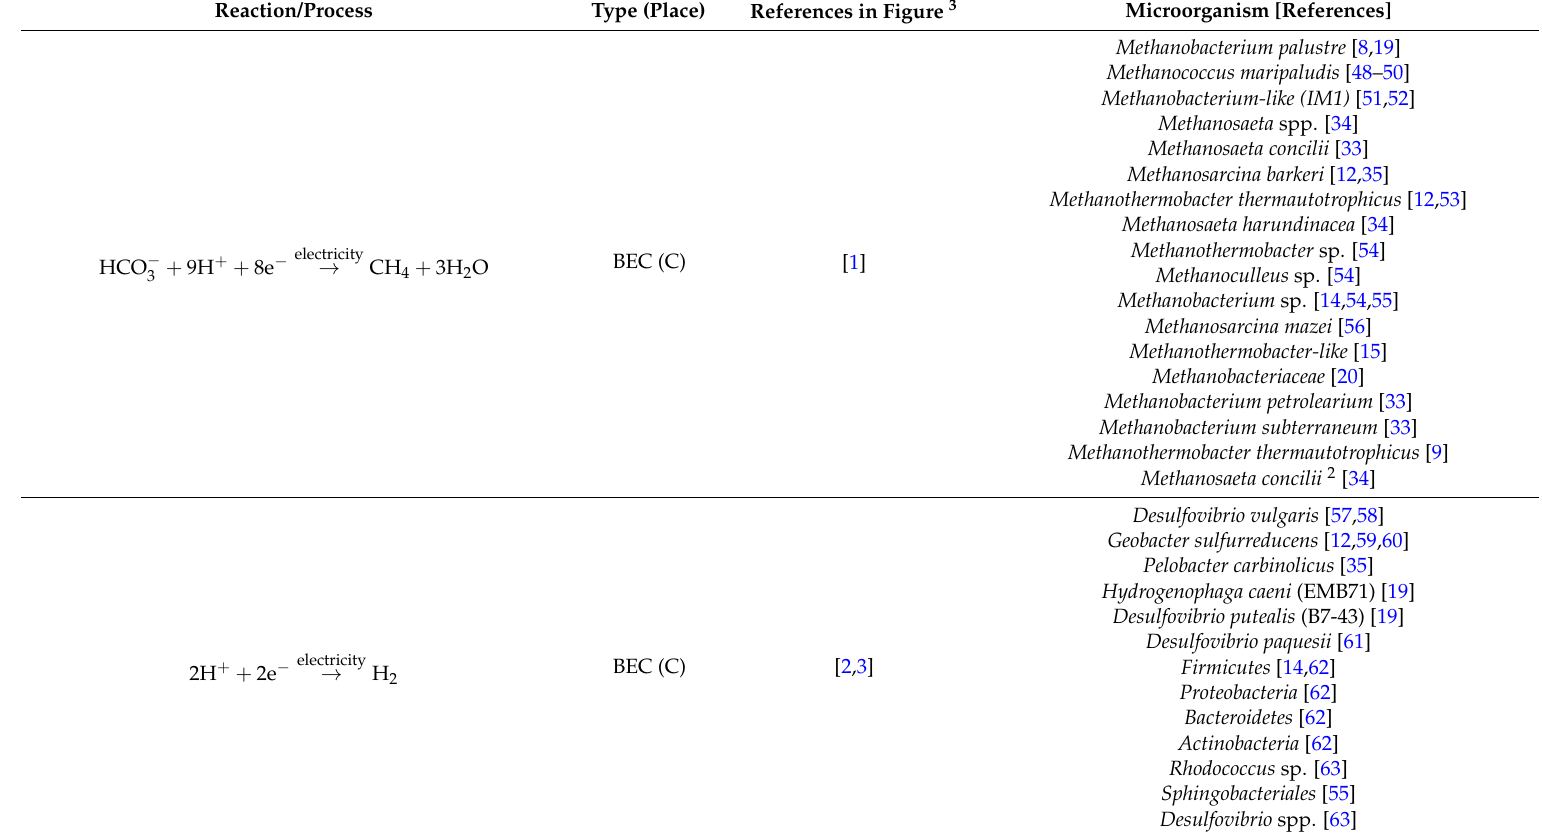
Table 1. Overview of the reaction equations that could occur in the possible electron transfer mechanisms of bioelectrochemical methane production. Based on reactions described in Van Eerten-jansen et al. 2014 [17]. Additionally, microorganisms described to possibly take part in the electromethanogenesis process are related to each